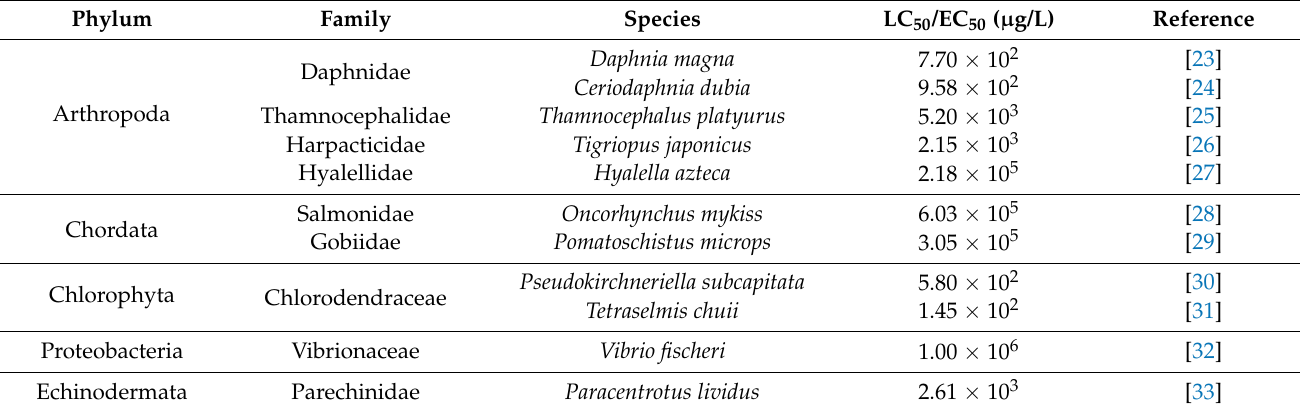
Table 1. Toxicity data of microplastic to aquatic species (LC 50 /EC 50